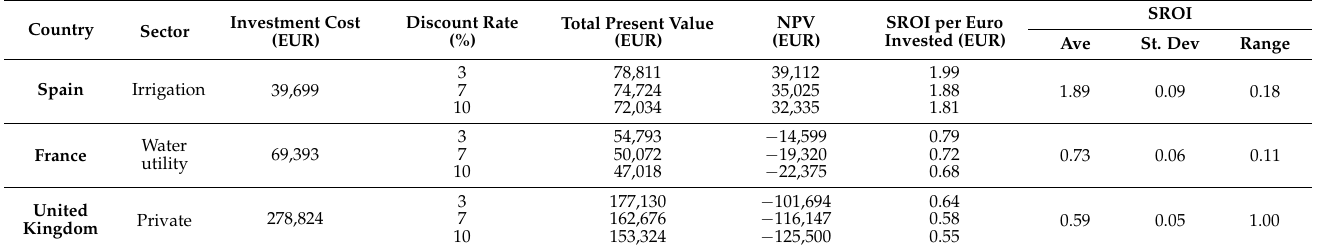
Table 7. Sensitivity of the SROI results to owner/manager input.